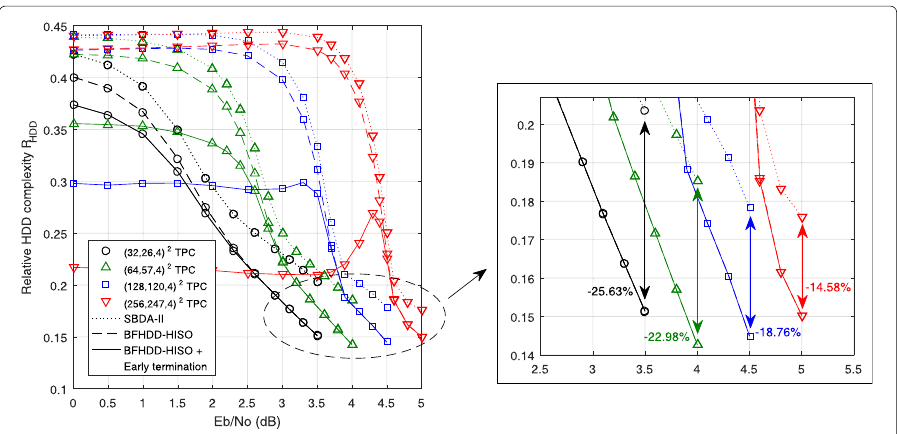
Fig. 9 Relative complexity results of four types of TPCs compared with the Chase-Pyndiah decoding algorithm [2] in terms of HDD requirements. ( I max ,8; LRB number,